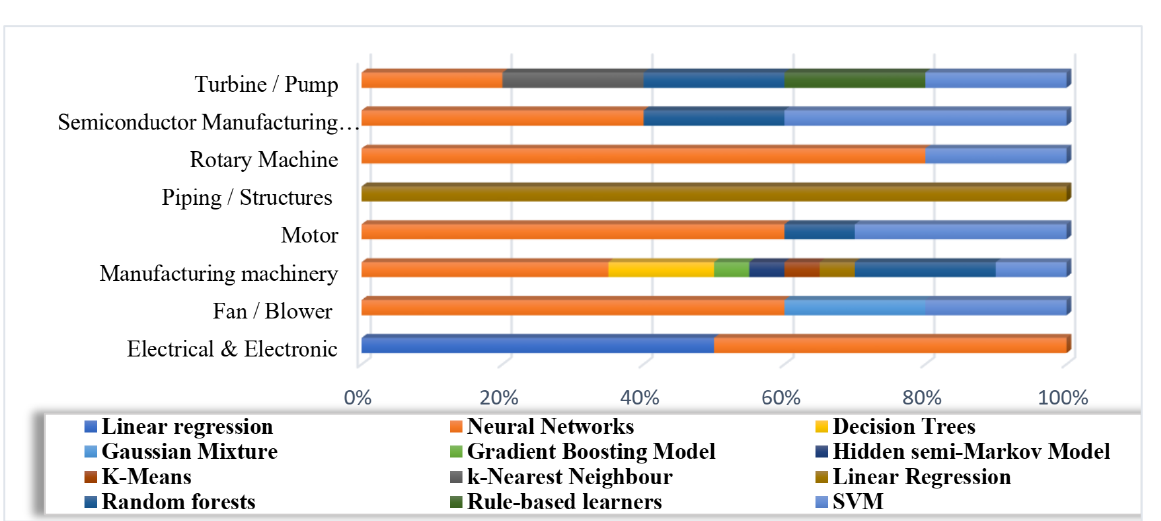
Figure 21. Relation between machine learning methods and type of investigated